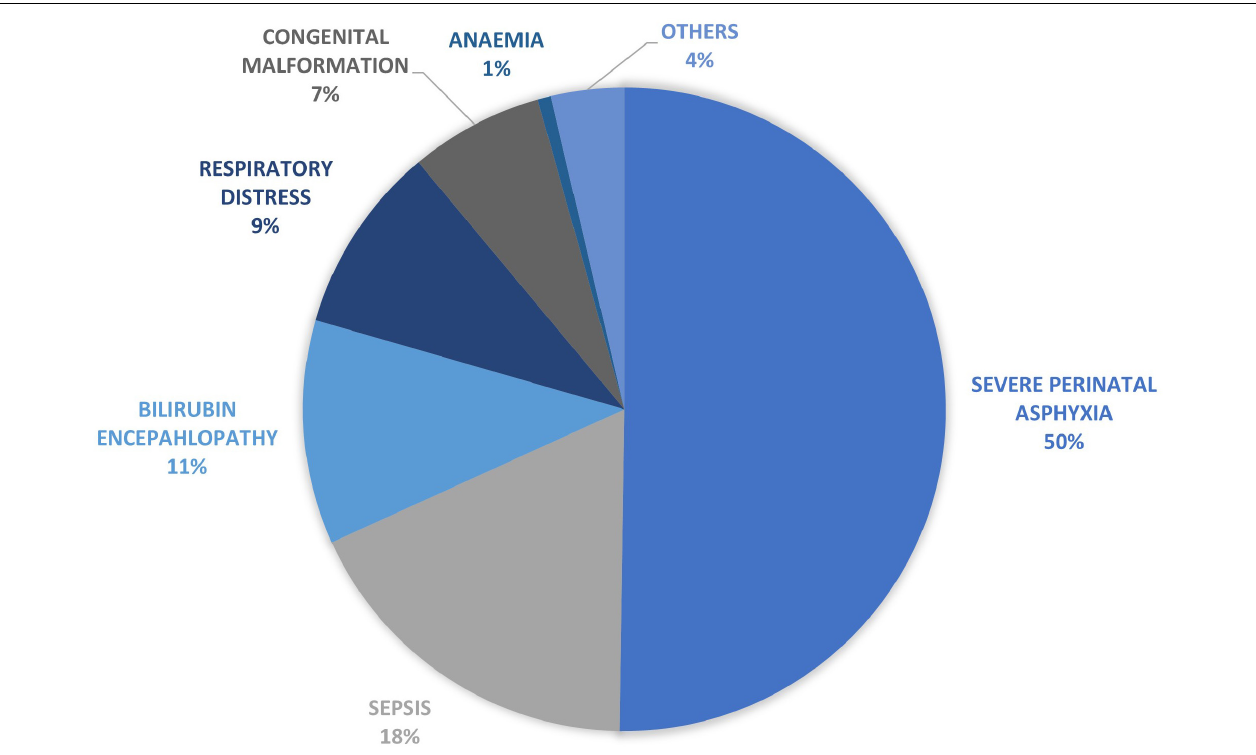
FIGURE 3 | Cause of mortality among term